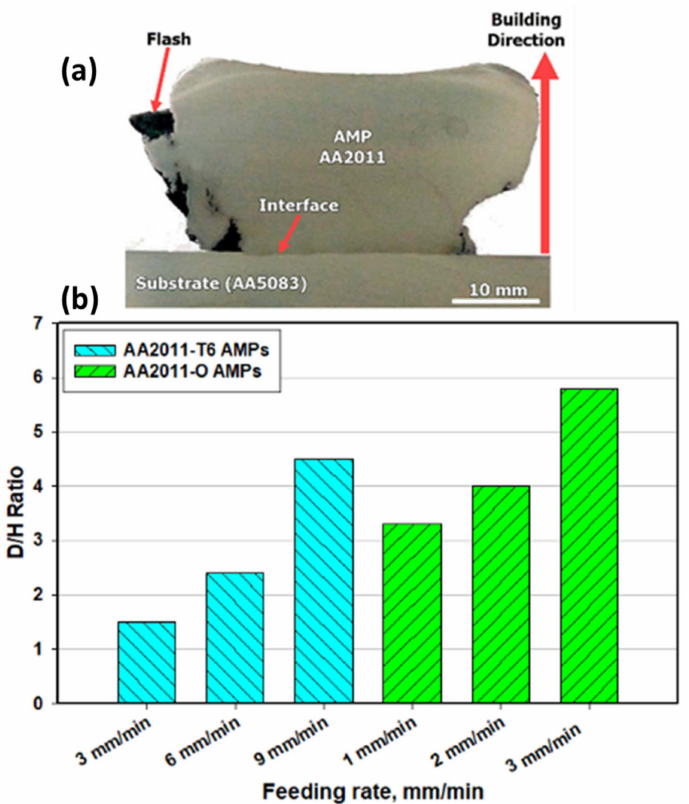
Figure 4. ( a ) The transverse cross-section macrograph for the AMP with the substrate with the building direction and the interface are indicated for the AMP at a constant rotational spindle rate of 1200 rpm and 6 mm/min feeding speeds, ( b ) AMPs Diameters/Height Ratio against feeding speed for all AMPs produced using the different temper conditions and different processing